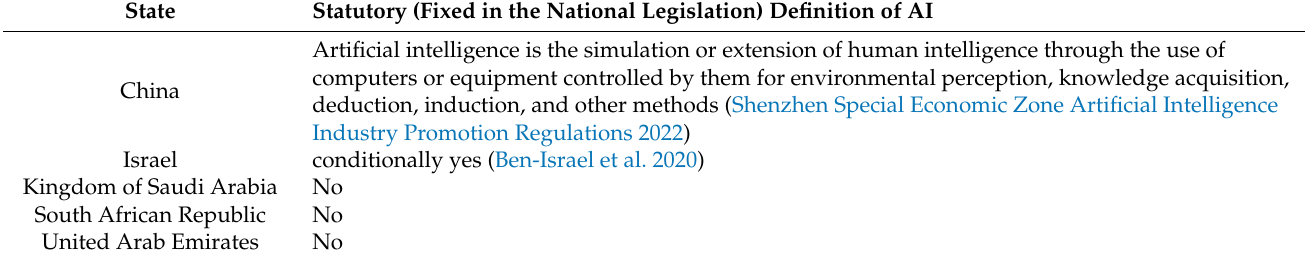
Table 6. Comparative analysis of fixed legislative approaches in countries representing